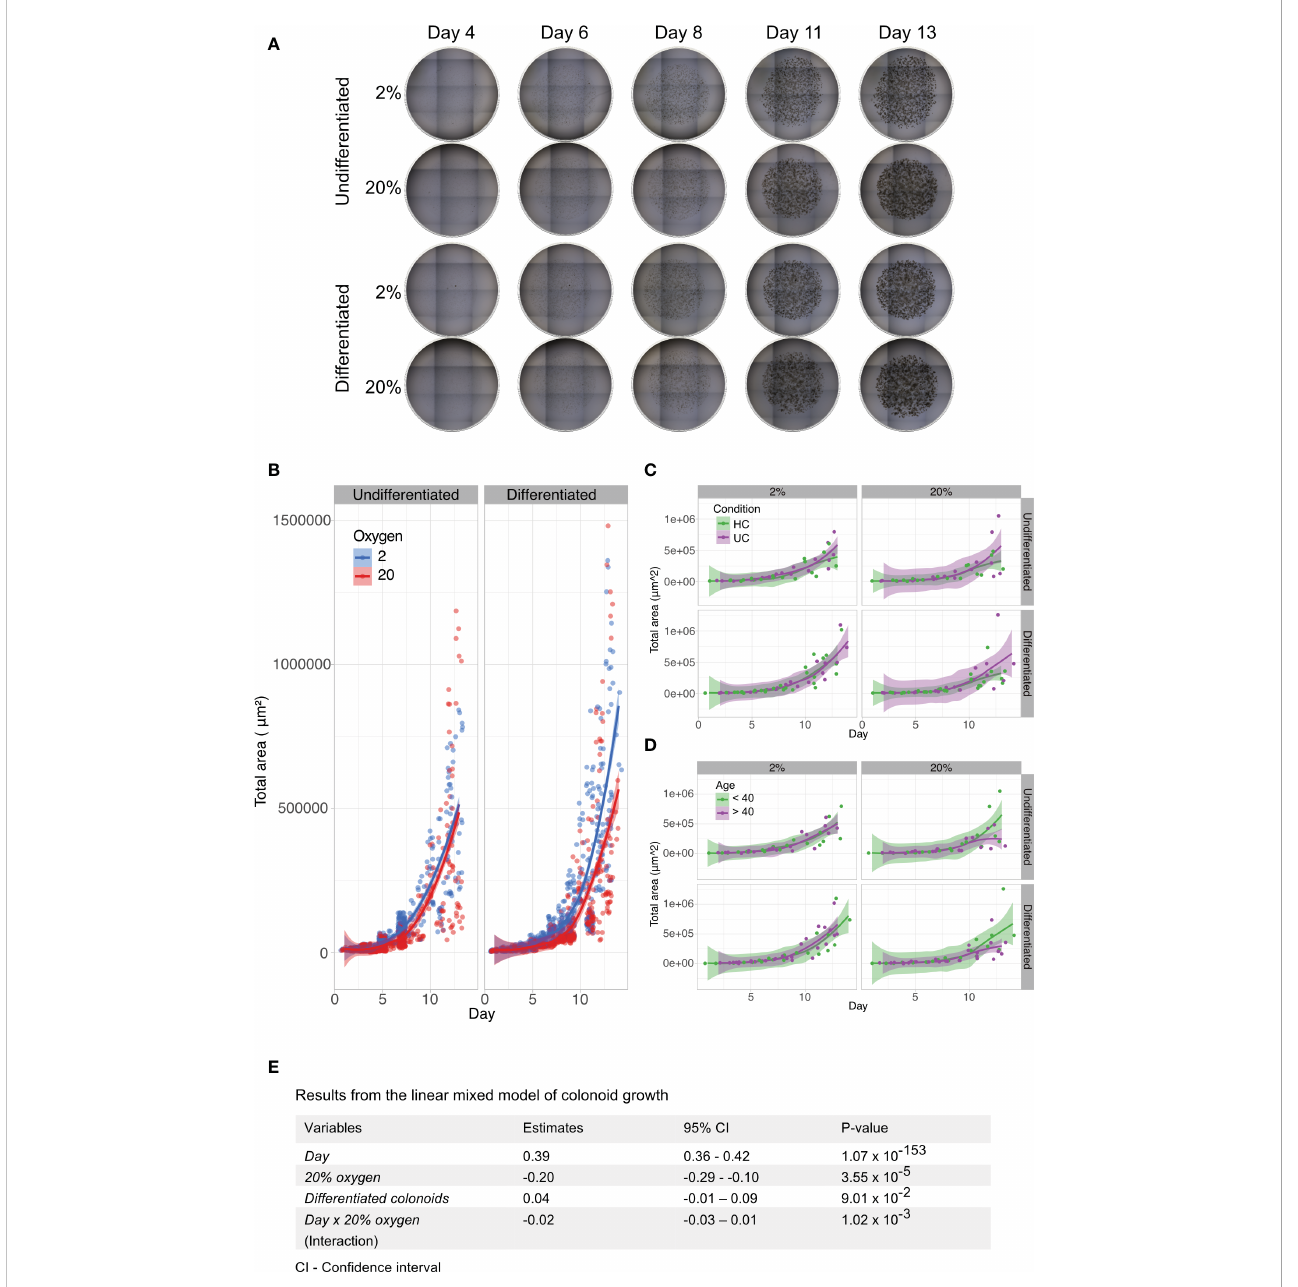
FIGURE 2 Bright fi eld image analyses and linear mixed model of colonoid growth. (A) Two dimensional (2D) bright fi eld images (4x magni fi cation, EVOS microscope) of Matrigel domes containing undifferentiated or differentiated colonoids cultured in parallel at 2% and 20% oxygen. Nine tiled images captured every dome within one technical replicate (i.e., plate well) throughout the experiment. The day of image acquisition is indicated above the images; the oxygen environment and the differentiation status are shown on the left. (B) Computational growth analysis of colonoid cultures (n=11 independent experiments, with 6-12 technical replicates (i.e., plate wells) per condition. Table 1 and Supplementary Figure 2B). Days are marked on the x-axis, while the y-axis shows the total colonoid mass in 2D. Timepoints with blue circles represent 2% oxygen cultivation, and red circles represent 20% oxygen cultivation in undifferentiated (left panel) and differentiated (right panel) colonoids. The blue (2% oxygen) and red (20% oxygen) lines were fi tted with the Loess curve fi tting model. (C) Colonoid growth curve of ulcerative colitis (n=2) and healthy control donors (n=5), with data from independent experiments with the same donor merged). The x-axis represents time, while the y-axis shows the total colonoid mass in 2D. Timepoints with purple circles represent ulcerative colitis donors, and green circles represent healthy control donors. Undifferentiated colonoids (left panel) and differentiated (right panel). The purple (ulcerative colitis) and green (healthy controls) lines were fi tted with the Loess curve fi tting model. (D) Colonoid growth patterns of donors < 40 years (n=3) and > 40 years (n=4)). The x-axis represents time, while the y-axis shows the total colonoid mass in 2D. Timepoints with purple circles represent old donors, and green circles represent young donors. Undifferentiated colonoids (left panel) and differentiated (right panel). The purple (> 40) and green (< 40) lines were fi tted with the Loess curve fi tting model. (E) A linear mixed model based on data from 1875 images was used to quantify which variables impacted colonoid growth. In the table, fi xed variables are listed in the fi rst column. The middle columns are absolute values of how much the variables affected growth, with an estimate of the impact in the left-middle column and 95% con fi dence intervals in the column to the right. P-values are listed in the last